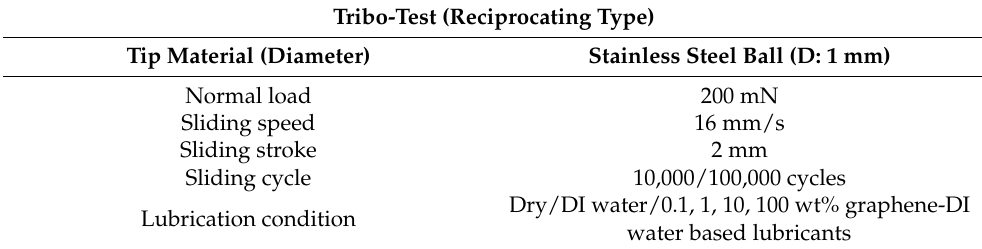
Table 2. Tribo-test